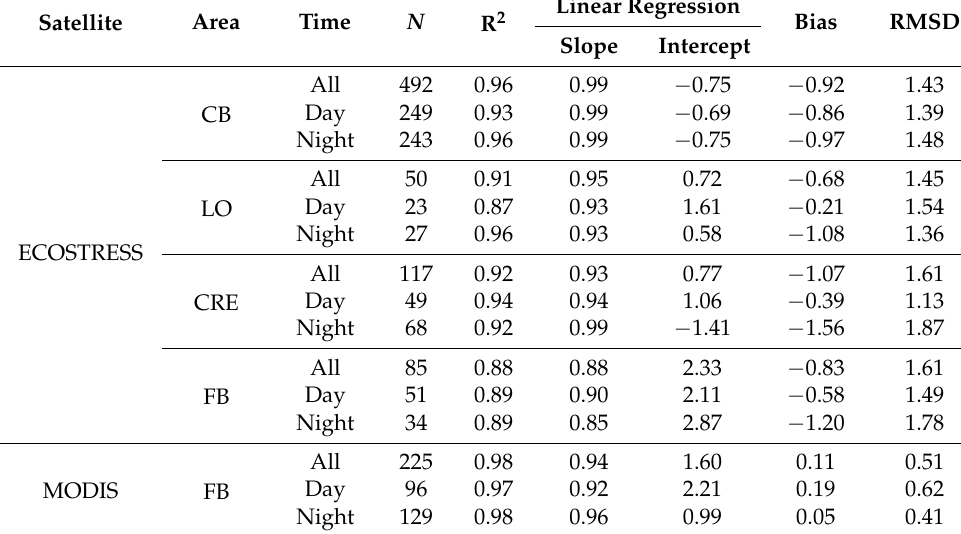
Table 2. Statistics of the matchup pairs between in situ SST and ECOSTRESS/MODIS SST from August 2018 to August 2020. Here, “Area” represents estuary or lake name. The time column indicates whether the data is collected in the daytime, or nighttime, or a combination of both (local time). N is the number of matching pairs, R 2 is the coefficient of determination, slope and Intercept are the linear regression coefficients between the two data sets, bias represents the mean absolute deviation in the ECOSRESS/MODIS data, and RMSD is the root mean square